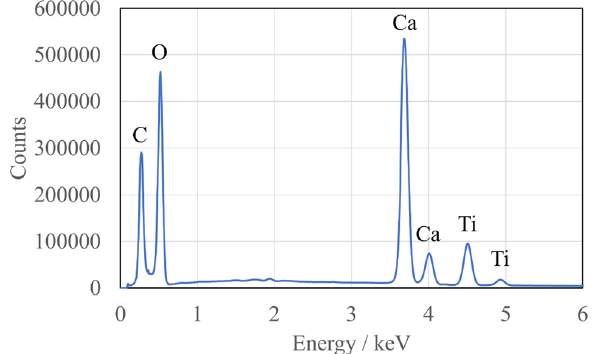
Fig. 6 Energy dispersive X-ray spectroscopy spectrum of the AuNP/ TiO /CaCO (4.0 g) catalyst 2 3